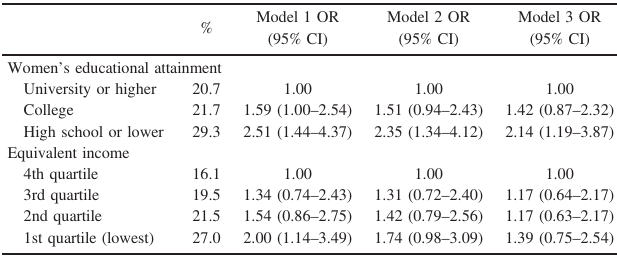
Table 2. Prevalence and odds ratios for poor oral health among unmarried women ( n = 626)